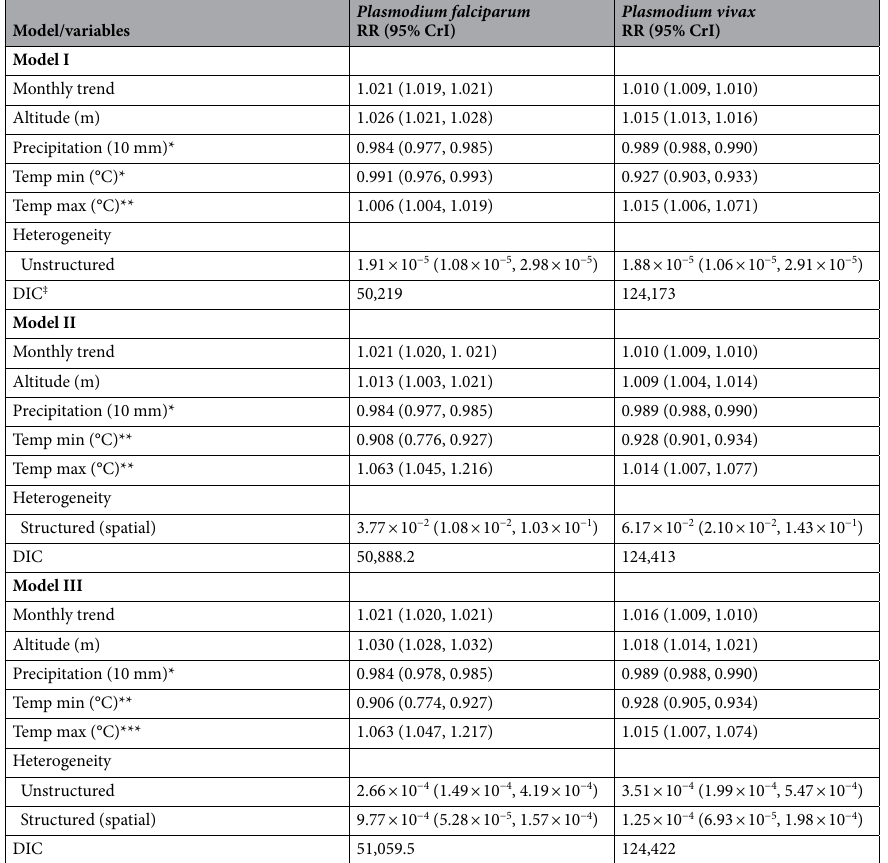
Table 2. Regression coefficients, relative risks and 95% CrI from Bayesian spatial and non-spatial models for Plasmodium falciparum and Plasmodium vivax from 2016 to 2018. CrI, credible interval; DIC, deviation information criteria; RR, relative risk. ‡ Best fit model. *Precipitation lagged at 6-months for both Plasmodium falciparum and P. vivax. **No lag and 6-months lag for P. falciparum and P. vivax. ***1 and 2-months lagged for P. falciparum and P.